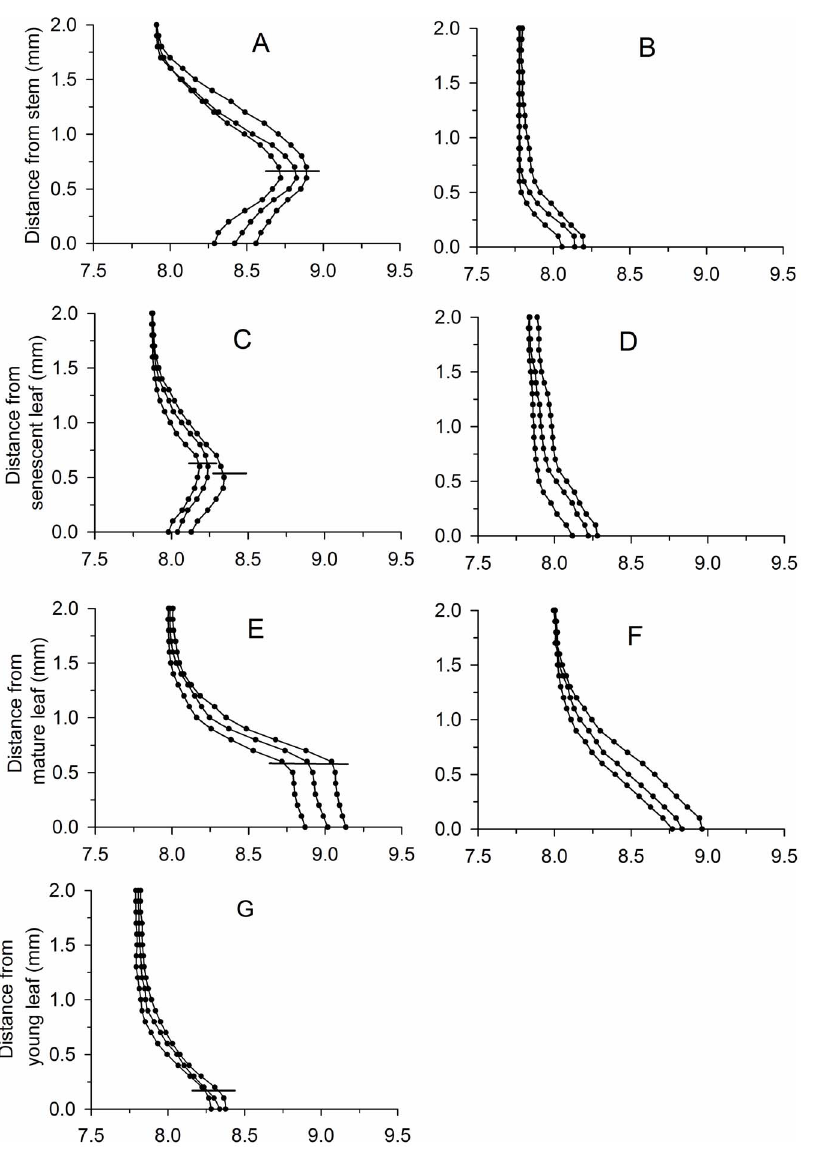
Figure 3. Microprofiles of pH around Potamogetonmalaianus stems and leaves with and without periphyton. A, C, and E, indicate thick periphyton; B, D, and F indicate periphyton removed; G indicates young leaves with a little periphyton. Microprofiles were measured at three different points under quantum flux density of 300 m mol photons ? m –2 ? s –1 on P. malaianus stems and leaves. The outer surfaces of the periphyton layer are indicated by horizontal bars. The leaf surfaces are indicated by 0. The microprofiles of pH around young leaves were not markedly different between the presence of little periphyton and periphyton removed. doi:10.1371/journal.pone.0101825.g003 PLOS ONE |